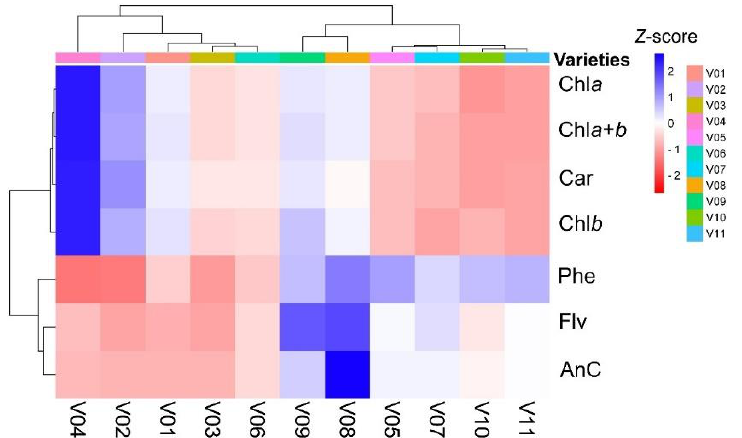
Figure 3. Cluster heatmap summarizing pigment contents from eleven varieties of Lactuca sativa L. (lettuces). Numerical differences within the data matrix are shown by the Z score of the color by scale red to blue indicate decreased to increased values, respectively. Parameters are clustered in the rows; sample groups are clustered in the columns by pigment content in leaves at independent factors. See varieties in Figure 1 or Abbreviation list. ( n = 132